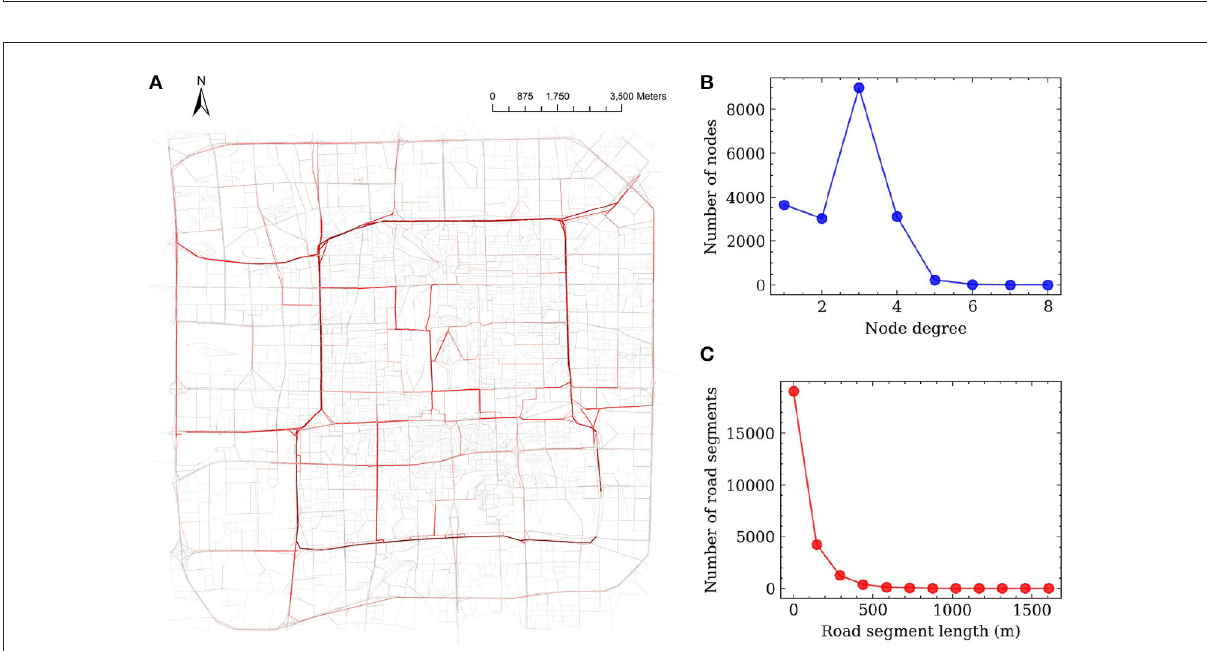
FIGURE9 Node degree distribution of Beijing Road network. (A) Betweenness centrality degree. (B) Node degree distribution. (C) Road length distribution.